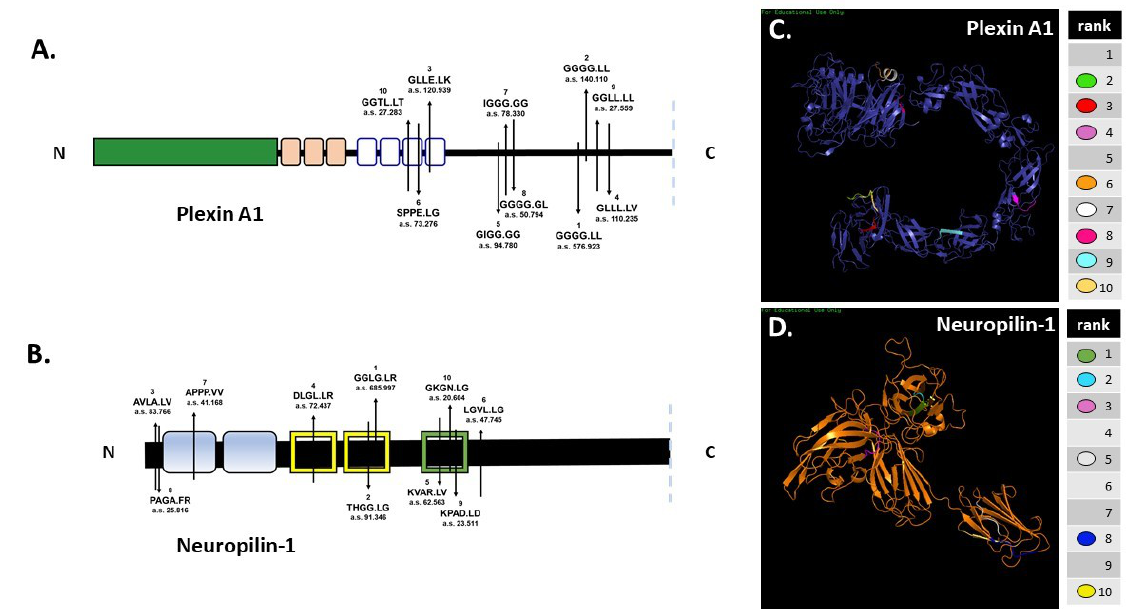
Figure 2. In silico predictions demonstrate MMP-7′s potential to cleave plexin A1 and NRP1 . In silico digestion of (A) plexin A1 and (B) NRP1 using MMP-7 cleavage sequence information in SitePrediction online software. Schematics of plexin A1 and NRP1 are shown with representative domains and relative location of the top ten predicted cleavage sites. Numbers represent the ranked score for each sequence with the corresponding amino acid sequence, with exact cleavage indicated by the period. PHYRE models of plexin A1 (C) and NRP1 (D) show the predicted ribbon structures with corresponding cleavage sites denoted by color.